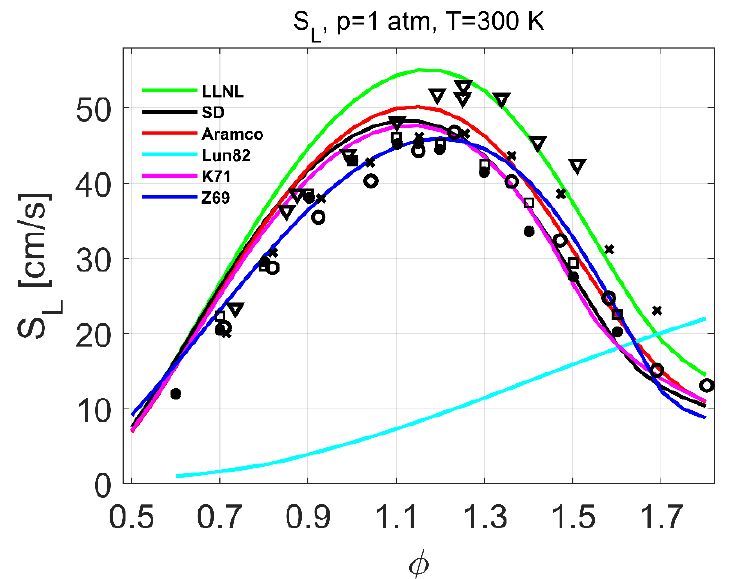
Figure 2. Laminar burning velocities for DME-air mixtures versus equivalence ratio, simulated at 1 atm and 300 K. Legend: experimental data for S L from ( ) Daly et al. [21], (×) Qin et al. [23], ( ) Vries et al. [26], ( ● ) Wang et al. [25], ( ▼ ) Zhao et al. [22]. Mechanism predictions from Z69 in blue, LLNL in green [28], Aramco in red [17], K71 in magenta [32], San Diego in black [30] and Pan82 in cyan [33].